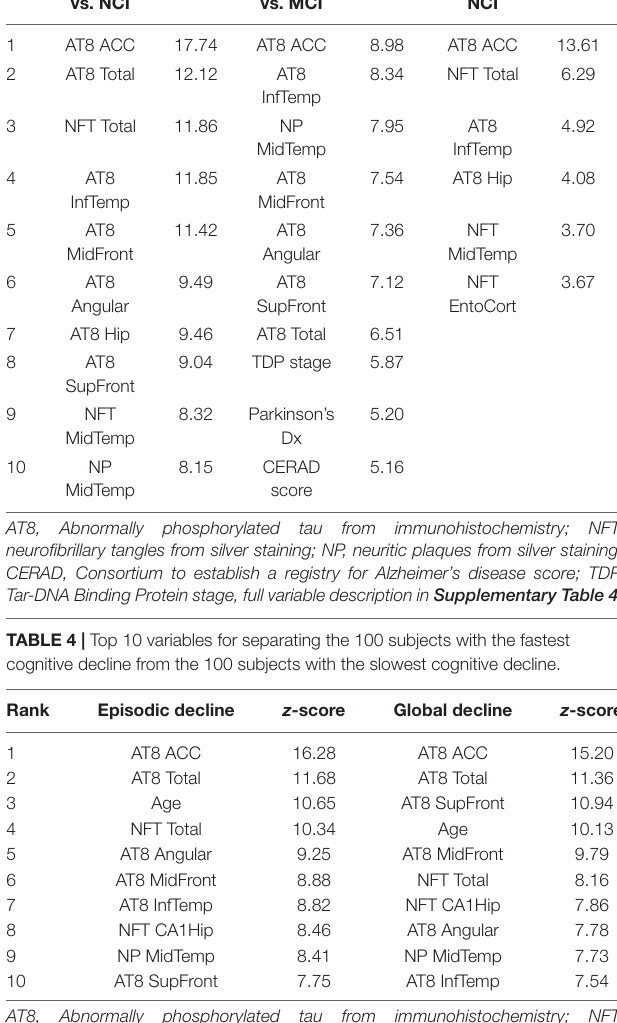
TABLE 3 | Top 10 pathology variables predictive of clinical diagnosis. Rank Dementia vs.